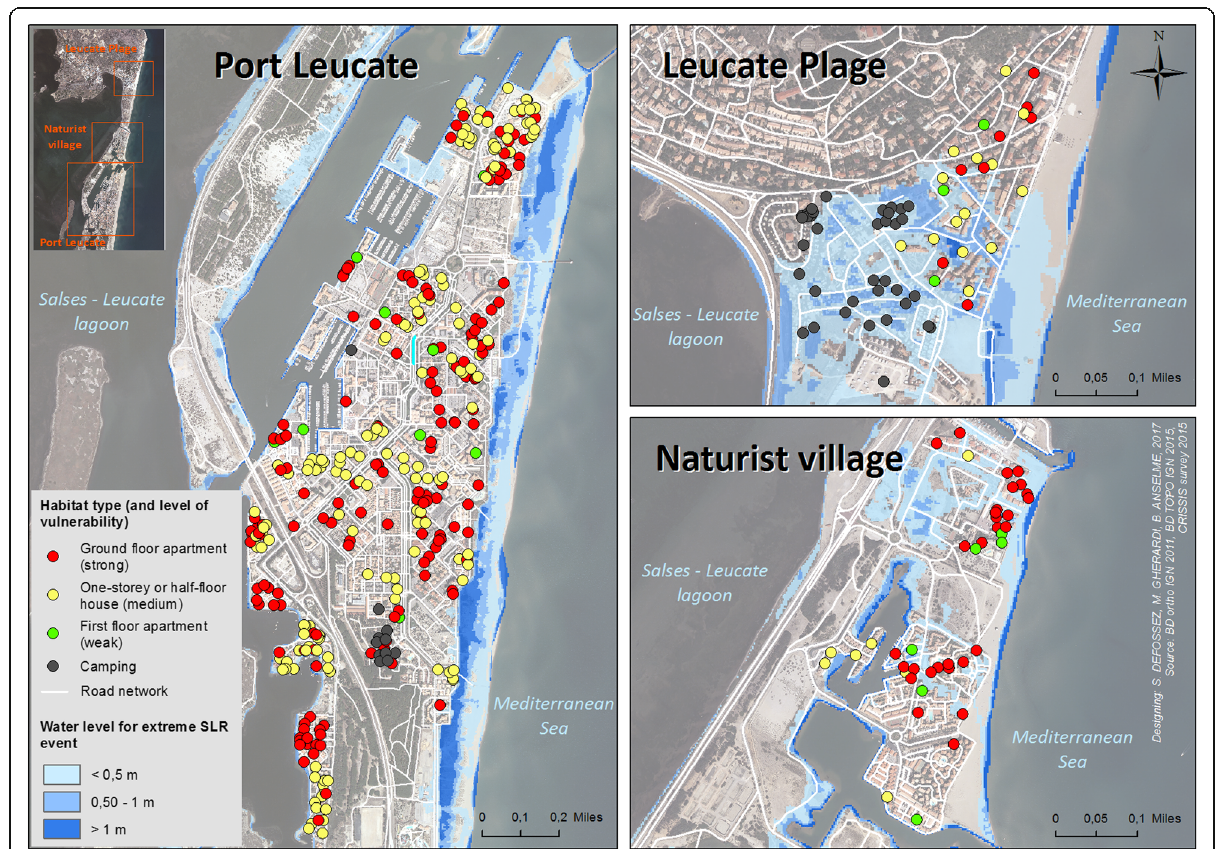
Fig. 4 Material vulnerability of people surveyed in Leucate (source: field